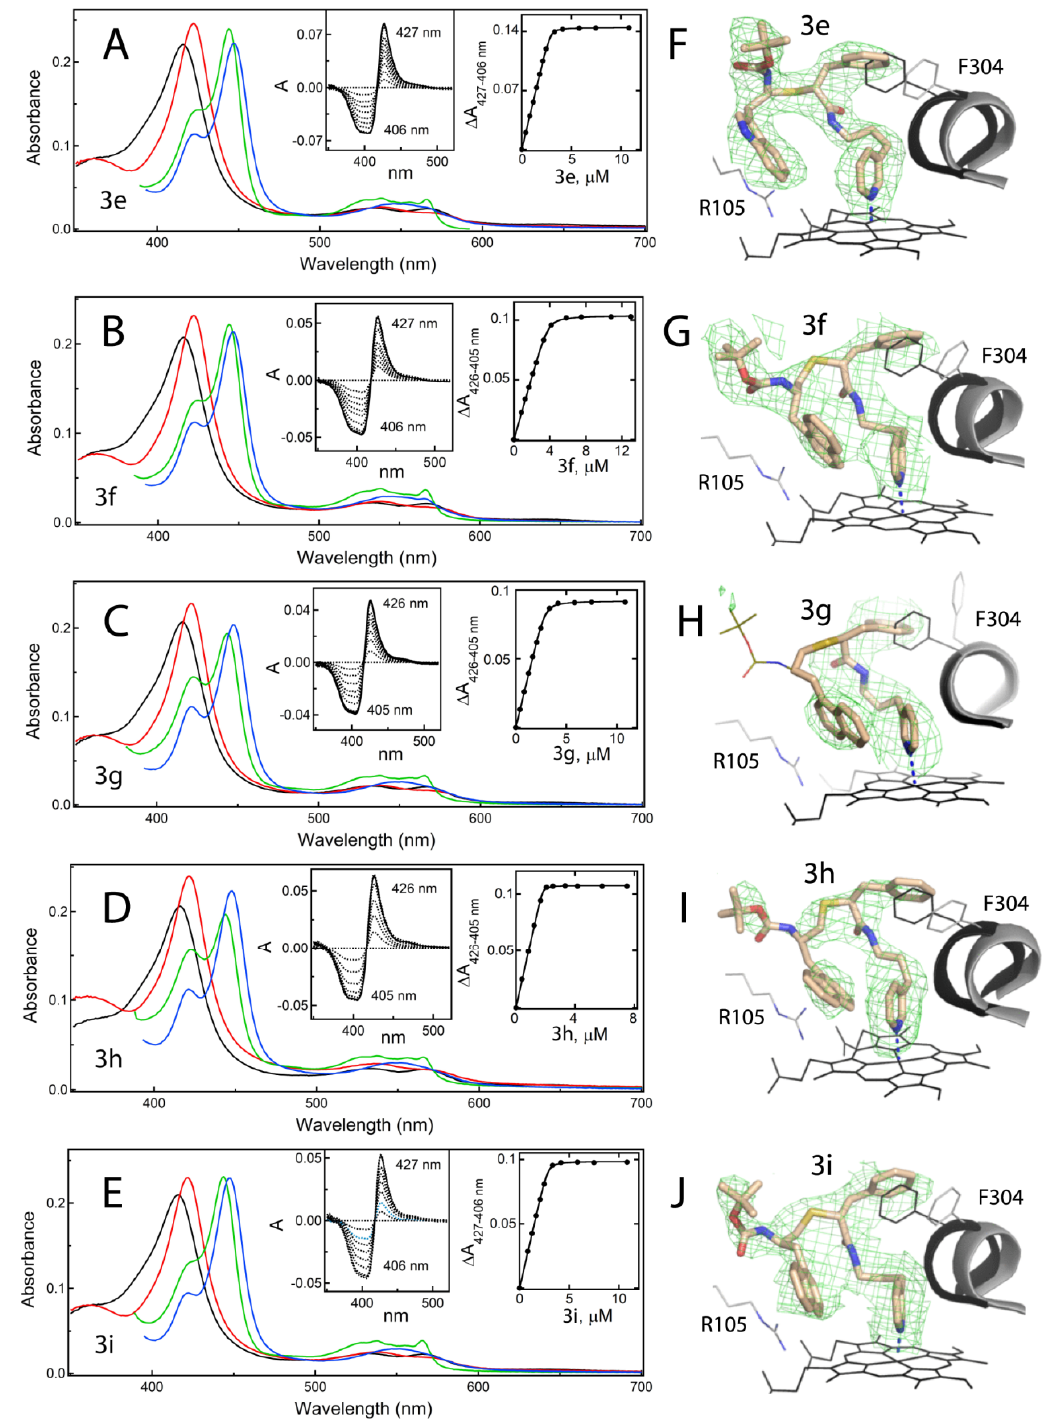
Figure 6. Spectral properties and binding orientations of 3e – i . ( A – E ) Spectral changes induced in CYP3A4 by 3e – i . Absorbance spectra of ferric ligand-free and inhibitor-bound CYP3A4 are in black and red, respectively. Spectra of ferrous ligand-bound CYP3A4 and its CO-adduct are in green and blue, respectively. Left insets are the difference spectra recorded during equilibrium titrations; right insets are titration plots with quadratic fittings. The derived K s values are listed in Table 1. ( F – J ) The binding modes of 3e – i observed in the crystal structures. Carbon, oxygen, nitrogen and sulphur atoms are shown in beige, red, blue and yellow, respectively. The adjacent I-helix and F304 in the inhibitory complexes and water-bound CYP3A4 (5VCC structure) are depicted in gray and black, respectively. Polder omit maps contoured at 3 σ level are shown as green mesh. The disordered tail of 3g is shown as thin lines.